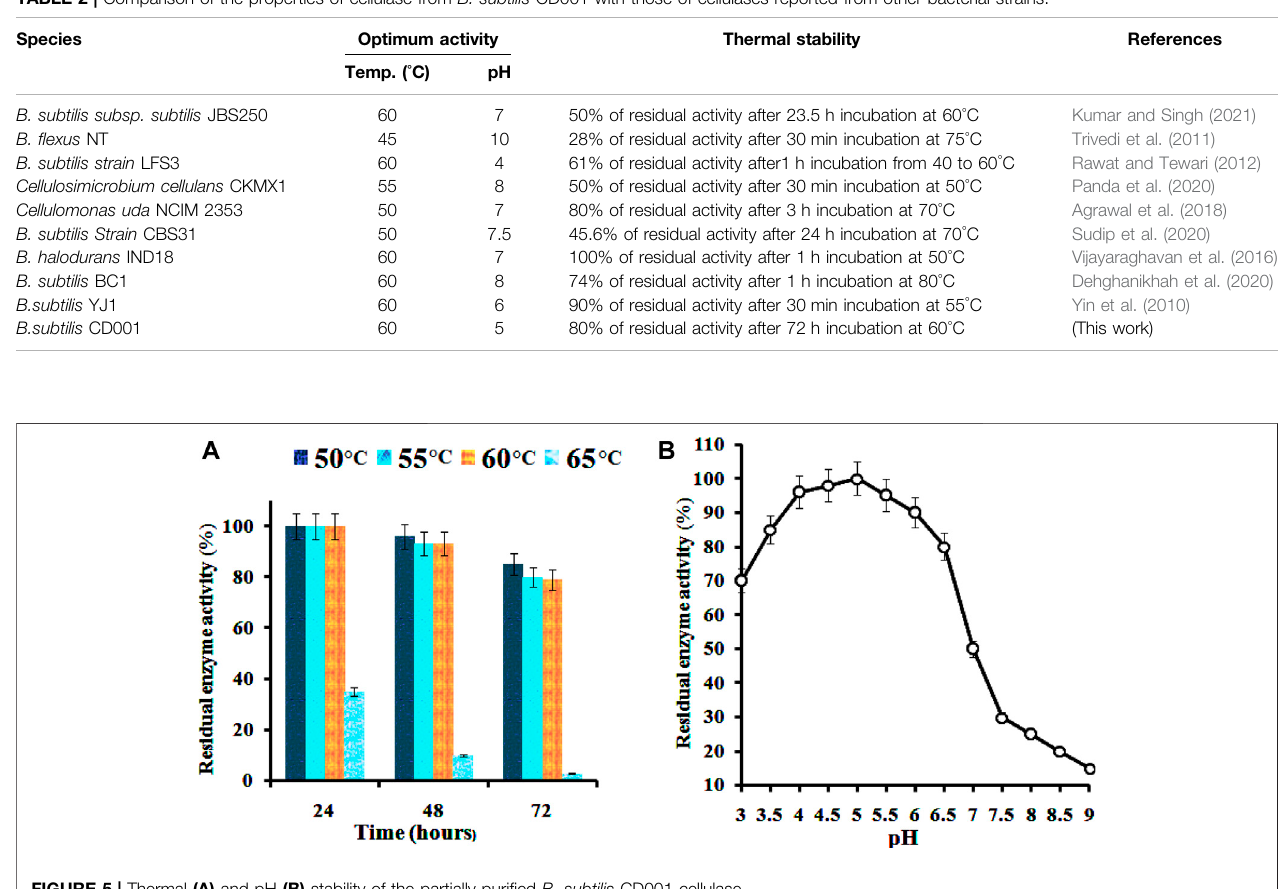
FIGURE 5 | Thermal (A) and pH (B) stability of the partially puri fi ed B. subtilis CD001